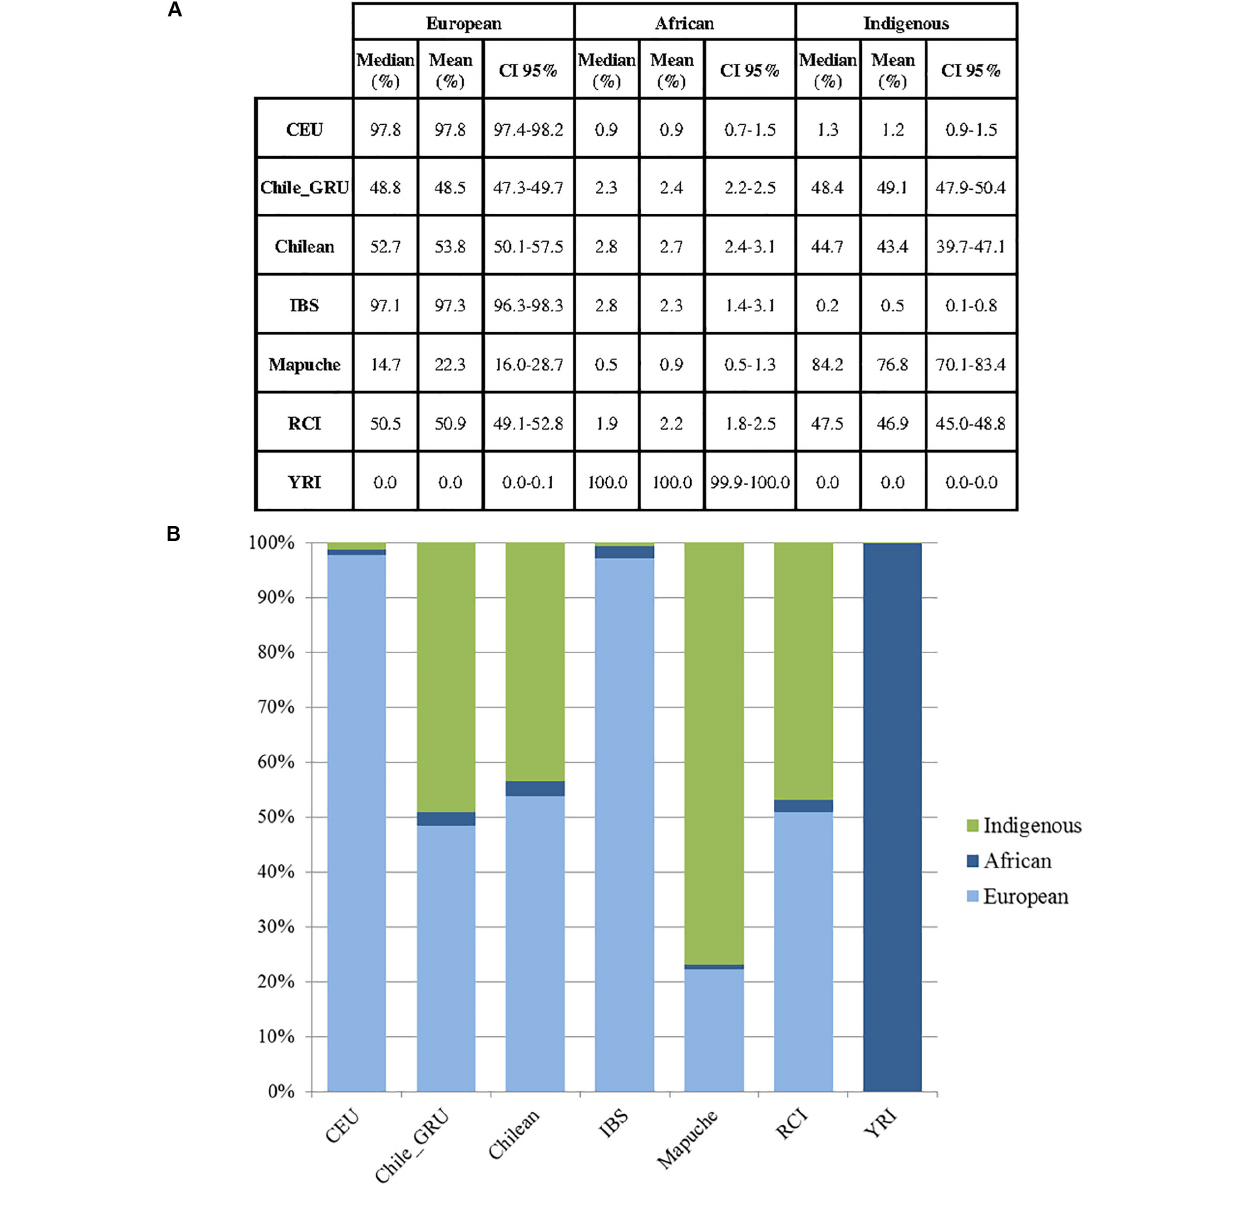
FIGURE 7 | (A) Estimates of ancestry summary statistics for populations in Europeans (CEU) ( N = 40), Chile_GRU (non-indigenous) ( N = 144), Chilean controls (from Santiago) ( N = 30), Iberian (IBS) ( N = 14), Mapuche ( N = 32), Robinson Crusoe Island (RCI) ( N = 86) and African Yoruba (YRI) ( N = 40) populations ( K = 3). Median, mean and confidence intervals shown. (B) Bar plots of estimated ancestry proportions for each population